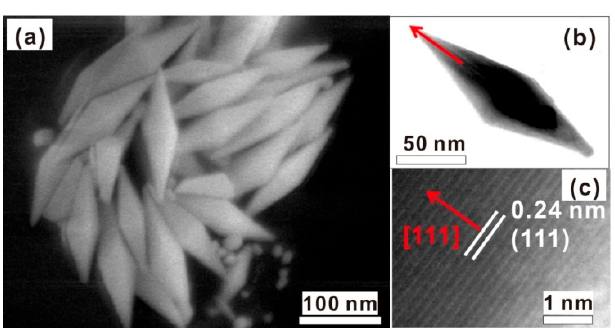
Figure 6. The morphology and microstructure of the products obtained by injecting the 50 μ L Au seeds at the rate of 50 μ L/min. ( a ) The FESEM image. ( b ) The TEM image of a single Au nanospindle. ( c ) The HRTEM image of ( b ) marked with an arrow. The arrows in ( b , c ) are parallel.